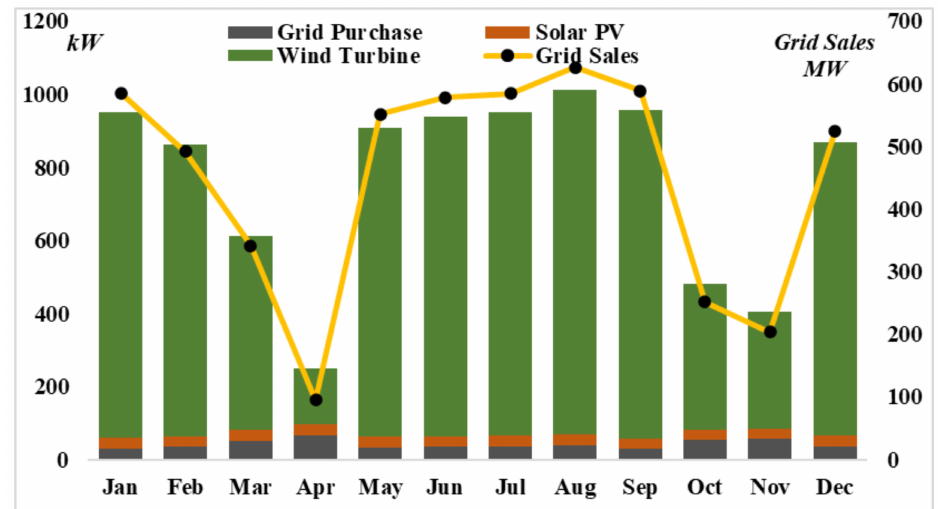
Figure 11. Monthly average electric production for the period of one year.